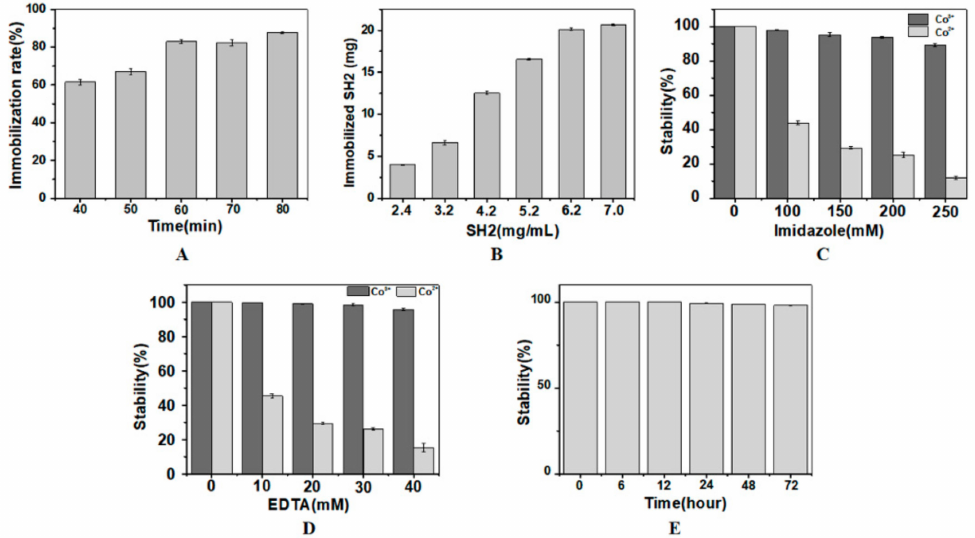
Figure 2. Immobilization of SH2. Optimization of H 2 O 2 oxidation time ( A ) and SH2 concentration ( B ) for SH2 immobilization. In ( A ), 50 mg SH2 at the loading concentration of 6.2 mg / mL was considered as 100%. Optimization of concentrations and incubation time of imidazole ( C ) and EDTA ( D , E ) for the stable immobilization of SH2. In ( A , B ), nanobody added in system was considered as 100%. In ( C , D ), the amount of immobilized SH2 washed by bu ff er without imidazole or EDTA was considered as 100%. In ( E ), the amount of immobilized SH2 treated by 150 mM imidazole and 20 mM EDTA for 2 h was considered as 100%. ( n =